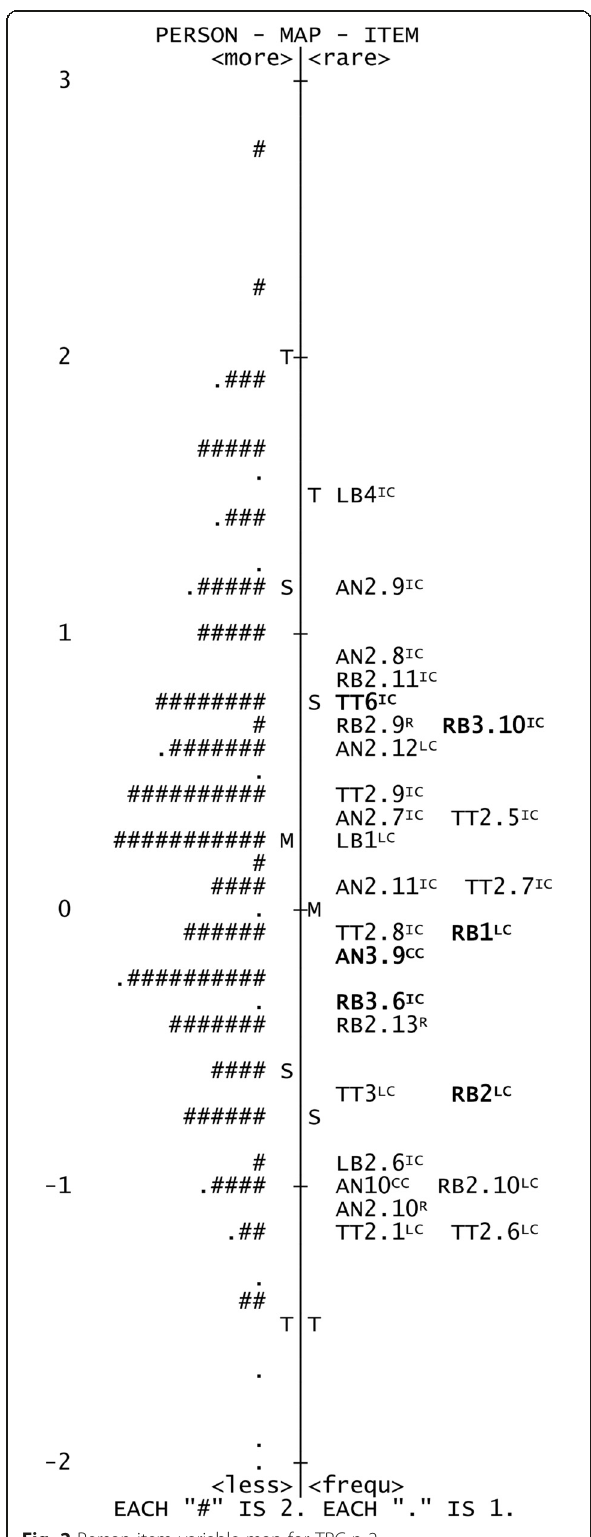
Fig. 2 Person-item variable map for TRC-n-2